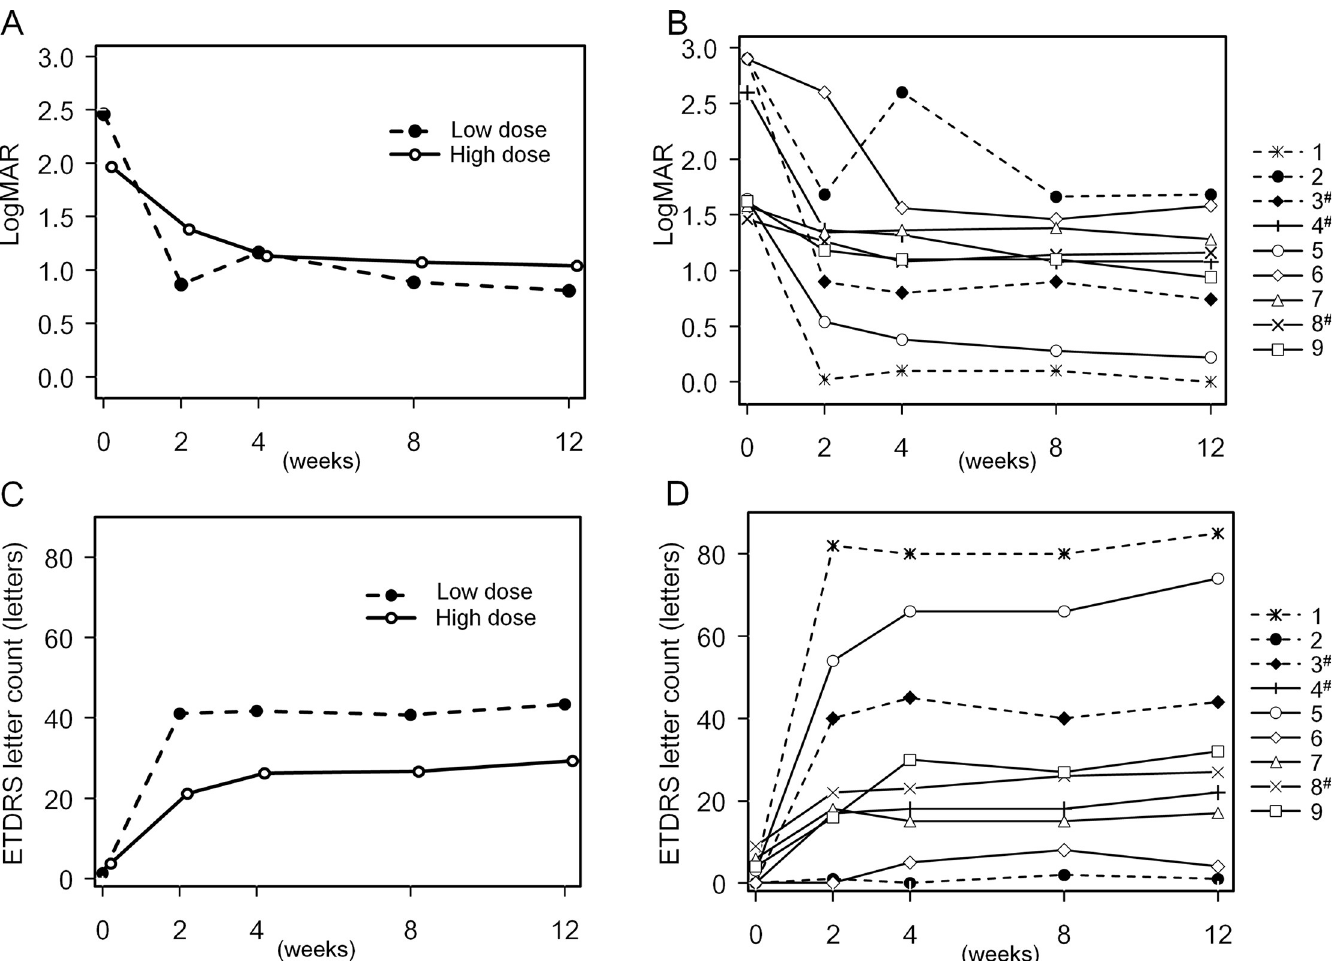
Fig 2. Time course of visual acuity. (A) Time course of the average logMAR tested on the ETDRS chart. (B) Time course of logMAR tested on the ETDRS chart for the nine patients enrolled in the trial. (C) Time course of the average readable ETDRS letter counts. (D) Time course of the readable ETDRS letter counts for the nine patients enrolled in the trial. Dotted line: low-dose group, full line: high-dose group. #: patient with patent cilioretinal artery in the objective eye, logMAR: logarithm of the minimum angle of resolution, ETDRS: Early Treatment Diabetic Retinopathy Study.